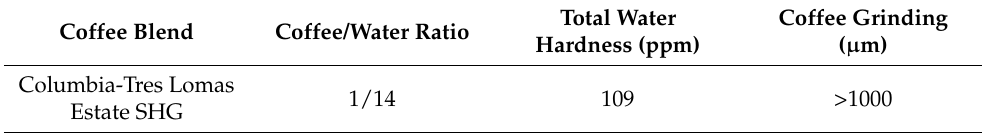
Table 2. Optimal extraction parameters 1